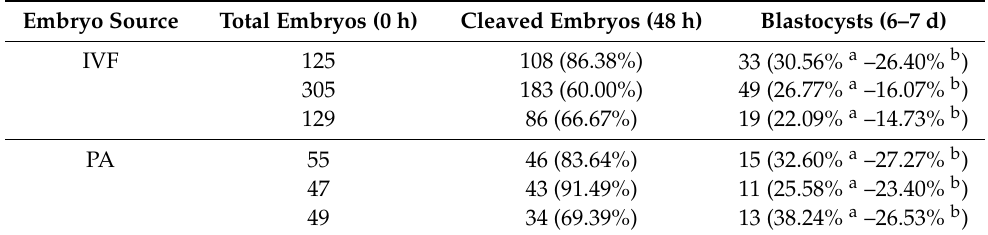
Table 1. In vitro embryo development of IVM (In vitro maturation) oocytes after IVF or PA. Embryo Source Total Embryos (0